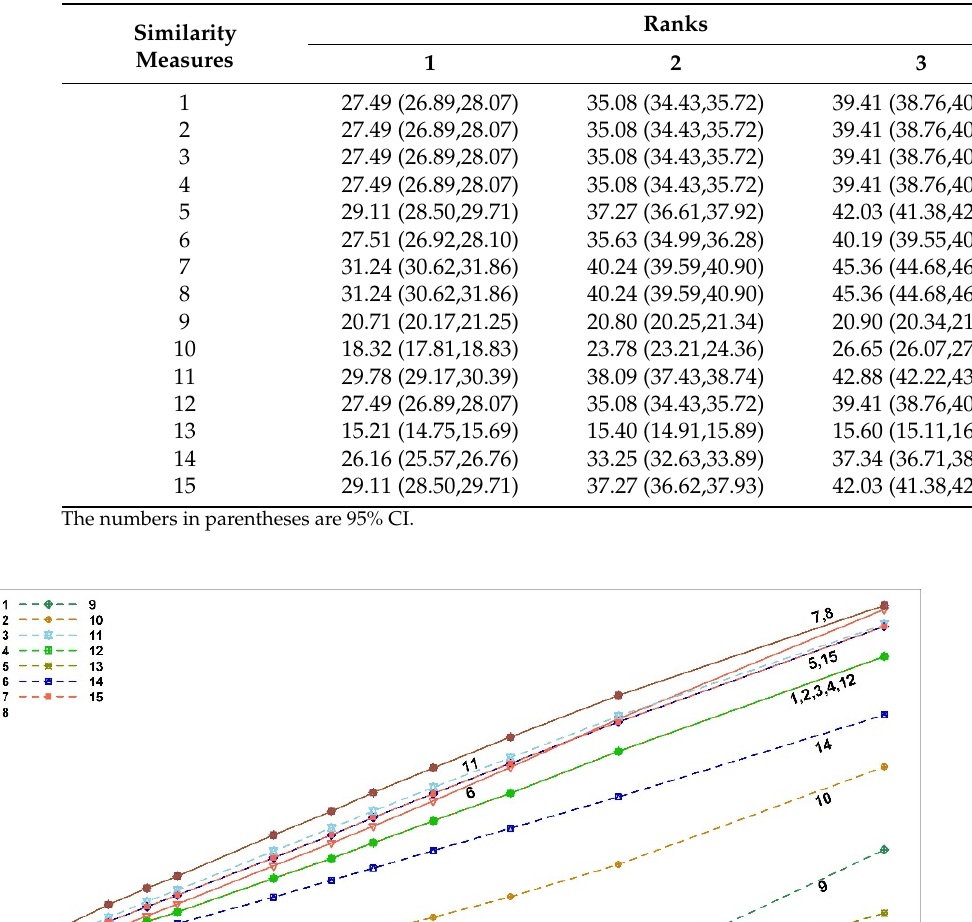
Table 1. Accuracy and 95% CI of the 15 binary similarity measures for the EI mass spectra-based compound identification up to the top three highest similarity scores.